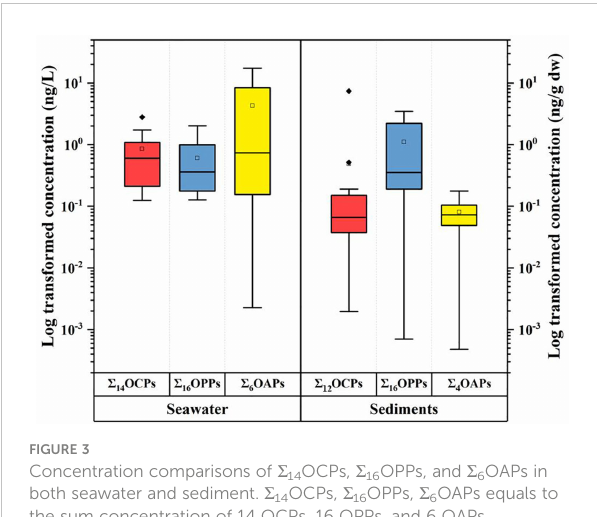
FIGURE 3 Concentration comparisons of S 14 OCPs, S 16 OPPs, and S 6 OAPs in both seawater and sediment. S 14 OCPs, S 16 OPPs, S 6 OAPs equals to the sum concentration of 14 OCPs, 16 OPPs, and 6 OAPs, respectively. The diamond represents outlier ’ s value and the square represents mean value.